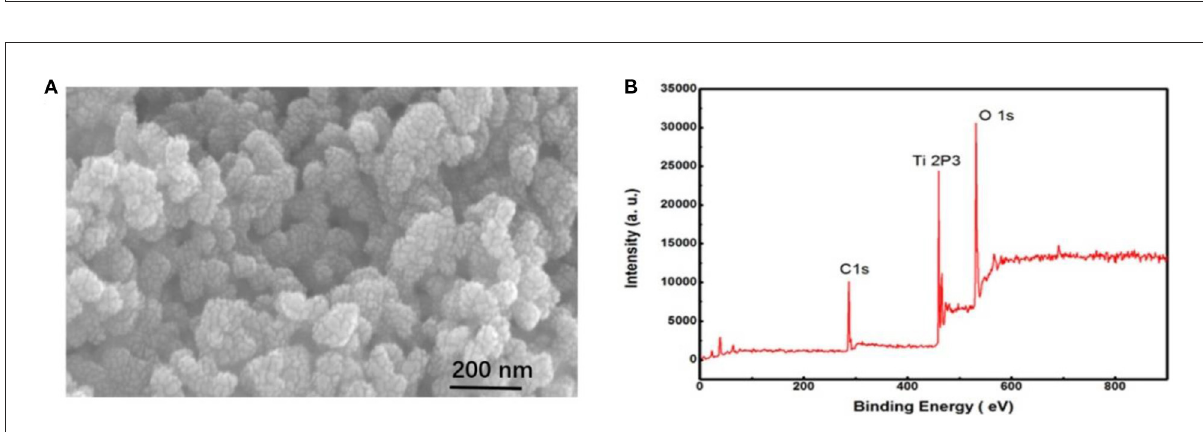
FIGURE2 SEM image and XPS characterization of TiO 2 :C-NPs. (A) SEM image of TiO 2 :C-NPs; (B) XPS characterization of TiO 2 :C-NPs.